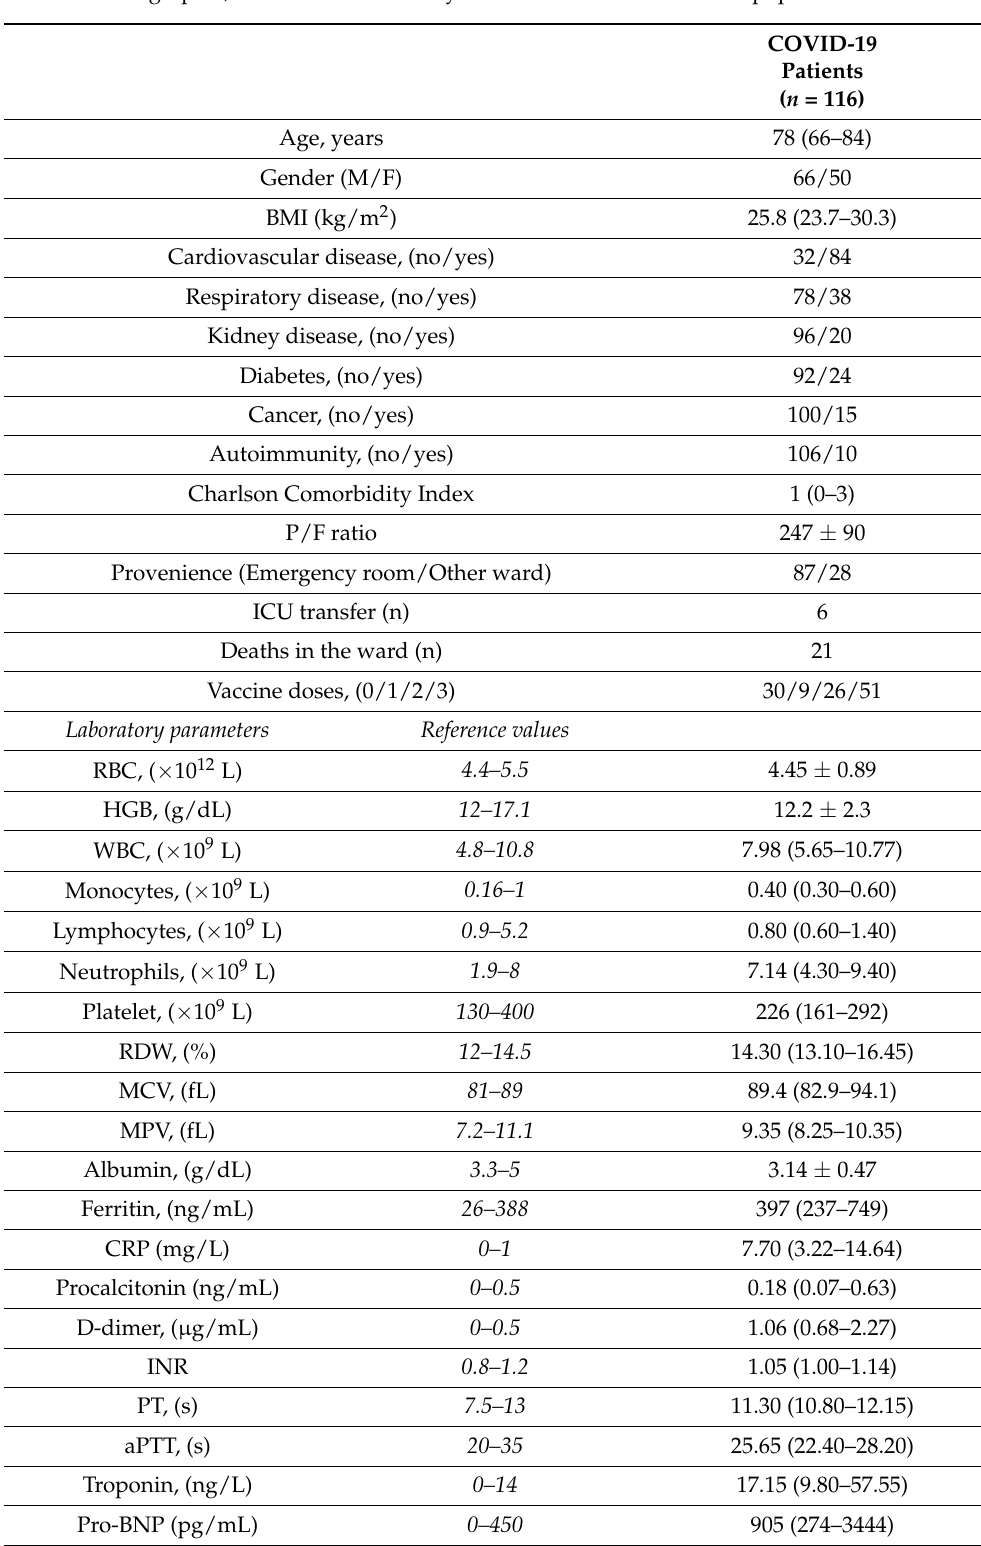
Table 1. Demographic, clinical and laboratory characteristics of the studied